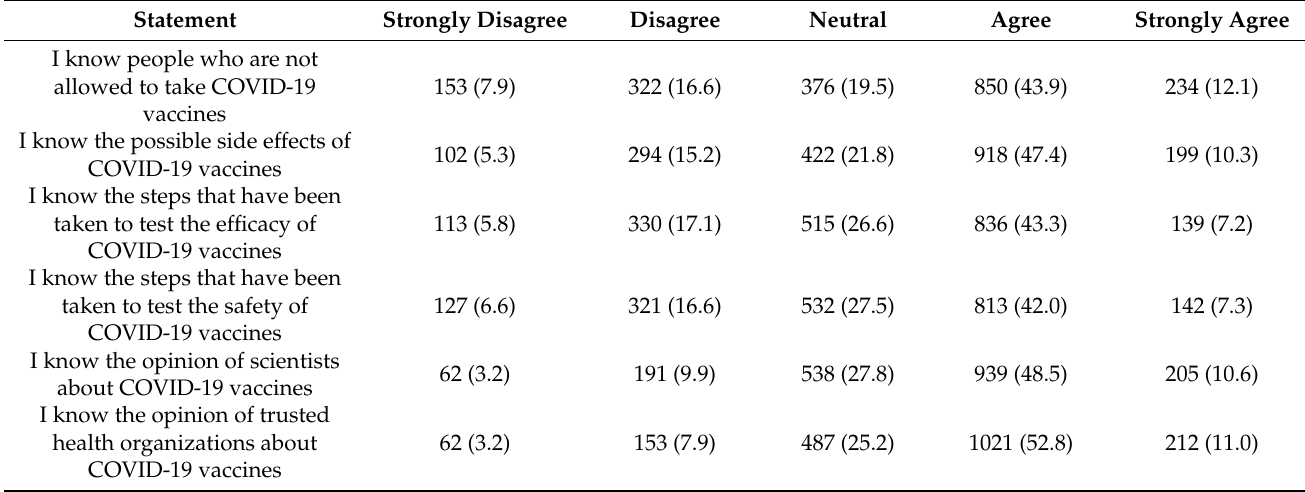
Table 2. Knowledge of participants about COVID-19